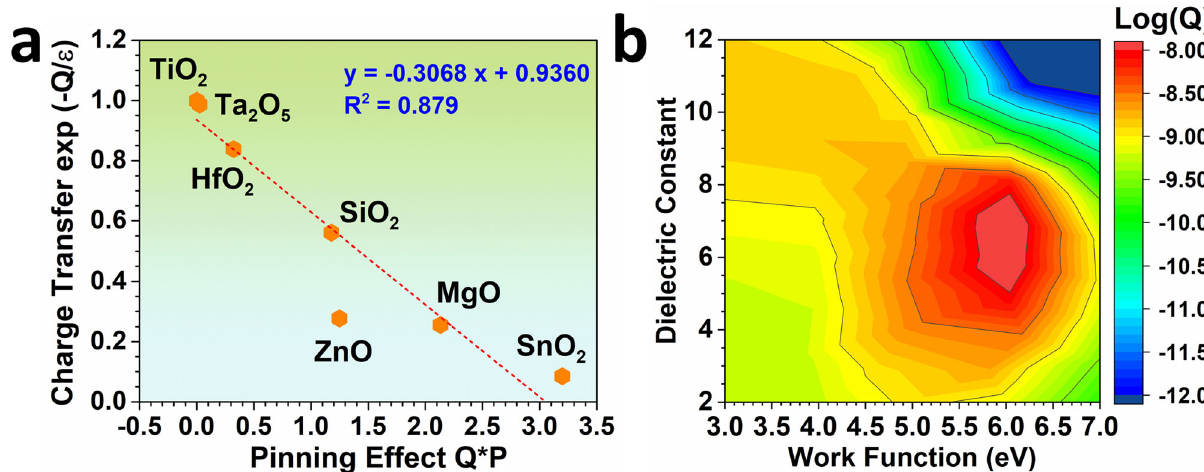
Fig. 5 The correlations between charge transfer at the liquid – solid interface and other parameters including pinning factor, work function and dielectric constant. a The linear correlation between charge transfer and dielectric function that is based on the introduction of the pinning factor. Q represents the charge transfer, ε represents the dielectric constant of the materials. P represents the pinning factor. b The correlation between work function, calculated dielectric constant, and charge transfer ( Q